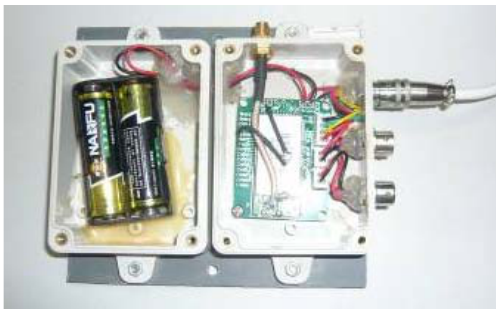
Figure 5. An encapsulated